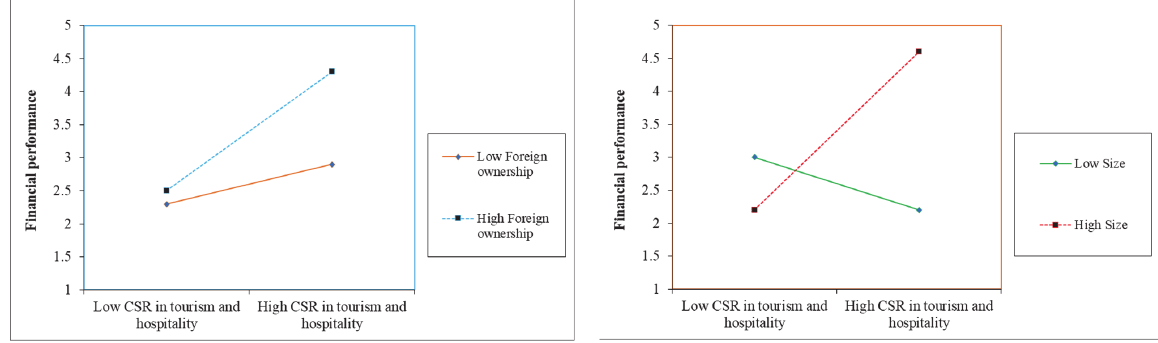
Fig. 4. Moderate role of Foreign ownership Fig. 5. Moderate role of